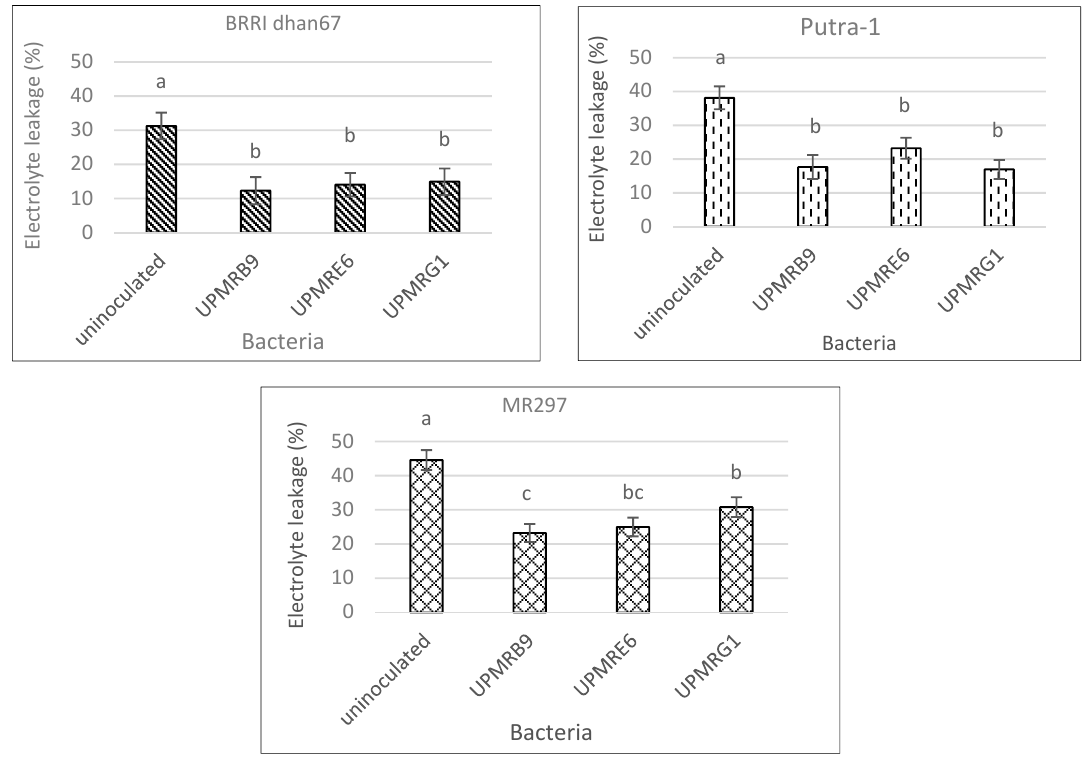
Figure 4. Effect of bacterial inoculation on electrolyte leakage of three rice varieties under saline conditions. Means with the same letter in a column do not differ significantly using Tukey’s test at p > 0.05.